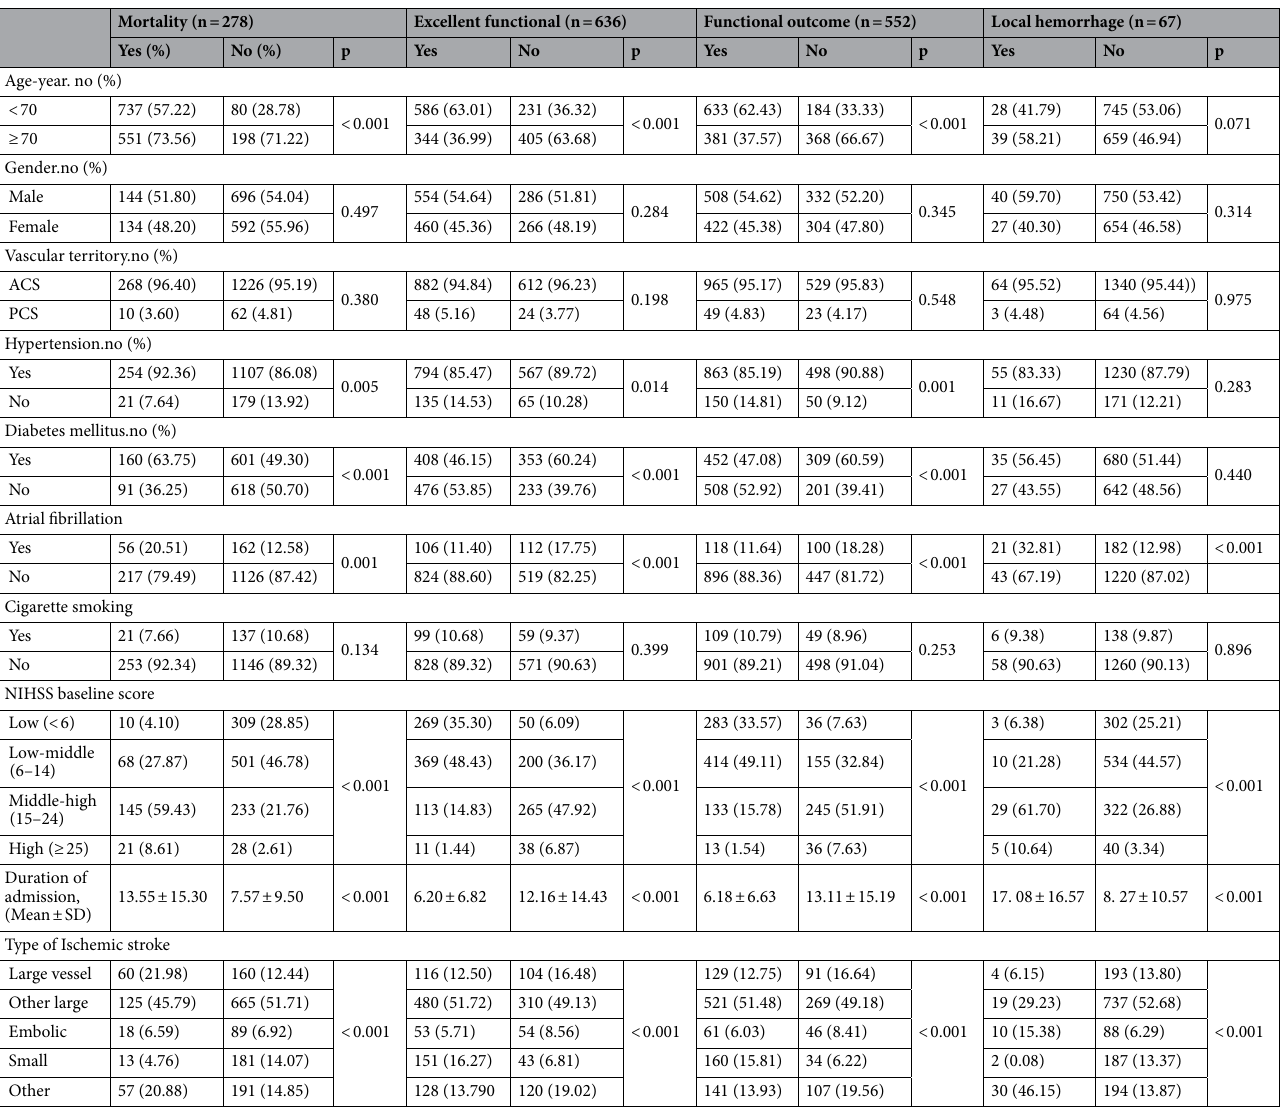
Table 2. Association of patient characteristics with outcome of IVT ischemic